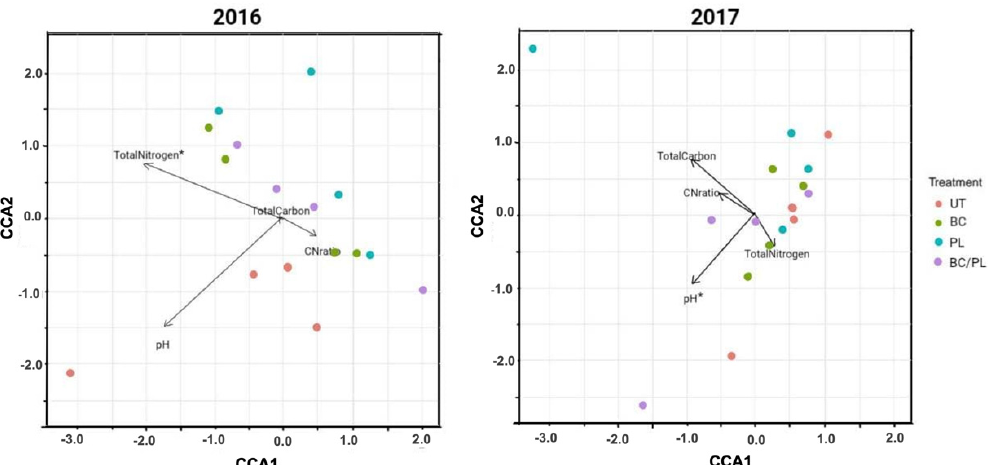
Figure 2. Canonical correspondence analysis (CCA) plots between the soil properties and bulk soil community structure of the soybean for 2016 and 2017, showing the vector of continuous environmental variables scaled by their correlation. Longer arrows denote “strong” predictors and the asterisk (*) indicates soil properties significantly correlated with the microbial community structure (BIOENV and Adonis test, p ≤ 0.05). Table 7. Correlation of environmental variable with the microbial composition showing the BIOENV that best explain the community variation and Adonis test in 2016 and 2017.